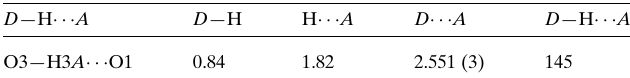
Table 1 Hydrogen-bond geometry (A˚ , (cid:3) ).